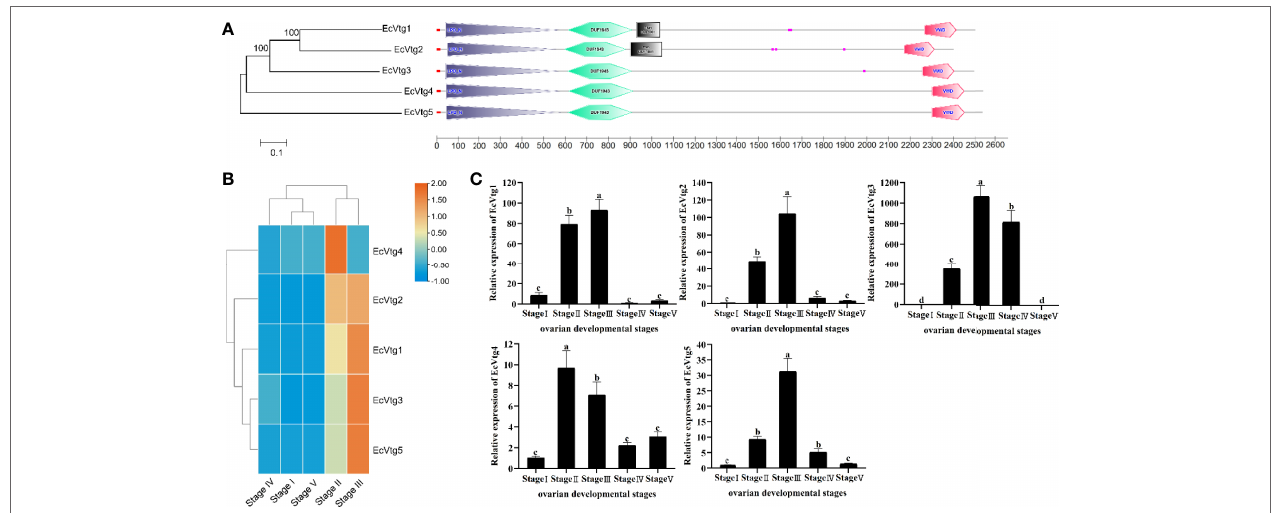
FIGURE 7 | The five types of vitellogenin genes in E. carinicauda (A) Schematic representation of gene structures of Vtg genes in E. carinicauda . The phylogenetic relationship was shown on the left. The functional domains were marked with different colors. The signal peptide is red line, the LPD_N domain is gray boxed, the DUF1943 is green boxed, the DUF 1081 is black boxed and the VWD is red boxed. (B) Visualizing the genes using a heatmap plot. The columns and rows indicate individuals and genes, respectively. The color scale represents FPKM after standard normalization. (C) The mRNA expression of EcVtgs in five ovarian developmental stages. Data with different letters significantly differ ( P < 0.05) among stages. Each bar represents the mean ± SE (n = 3). The β -actin serves as internal reference